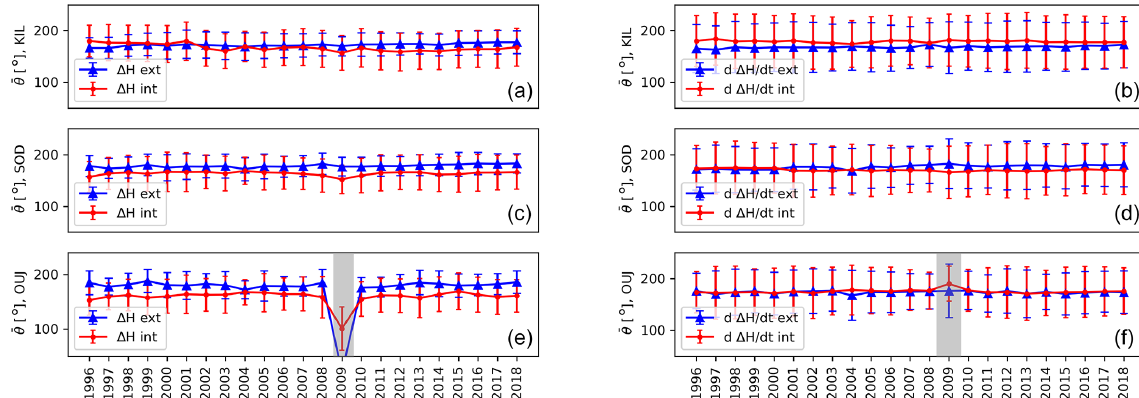
Figure 10. Mean directions, θ , and standard deviations (error bars) of external and internal (cid:49) H (a, c, e) and d (cid:49) H / d t (b, d, f) as a function of year at KIL, SOD and OUJ, 1996–2018. (cid:49) H ext is marked with blue triangles and (cid:49) H int with red dots. The gray shading indicates very few events (less than 100) fitting the criterion in OUJ